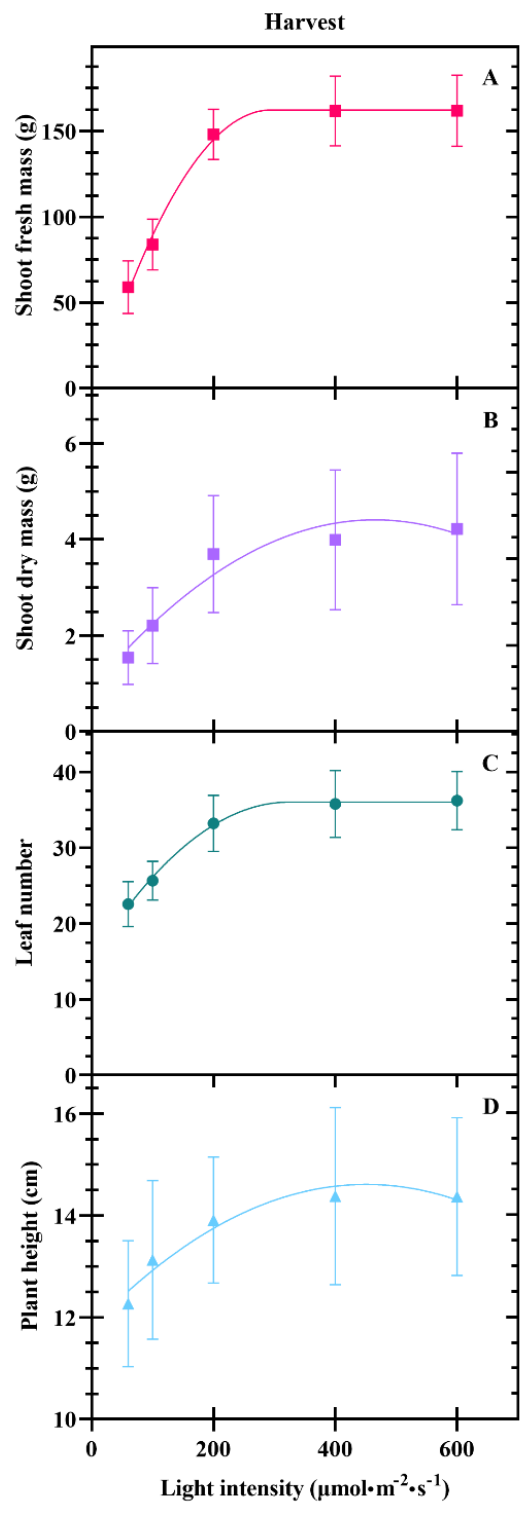
Figure 4. Fresh mass ( A ), dry mass ( B ), dry matter concentration ( C ), leaf number ( D ) of butterhead lettuce ‘Rex’ ( Lactuca sativa ) seedlings grown under light intensities of 60, 100, 200, 400, or 600 µmol·m − 2 ·s − 1 for a 24-h photoperiod for 14 d and then transplanted into a common greenhouse environment and grown for 21 d. Each symbol represents the mean of 30 plants ± SE. Lines represent linear, quadratic, or quadratic plateau regression. Equations and significance are reported in Table 4.